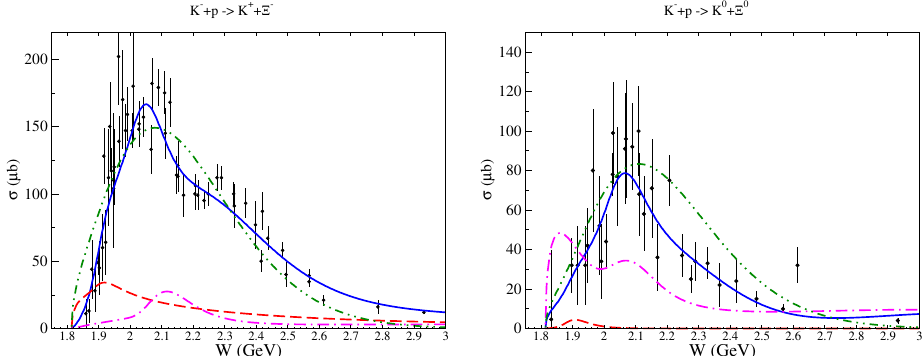
Figure 2. Total cross section for the K − + p → K + + Ξ − and K − + p → K 0 + Ξ 0 reactions. The solid blue line represents the result of the full calculations of the present model. The red dashed line shows the combined contribution of Λ hyperons. The magenta dash-dotted line shows the combined contribution of Σ hyperons. The green dash-double-dotted line gives the contribution from the contact term. The experimental data are adopted from Ref.